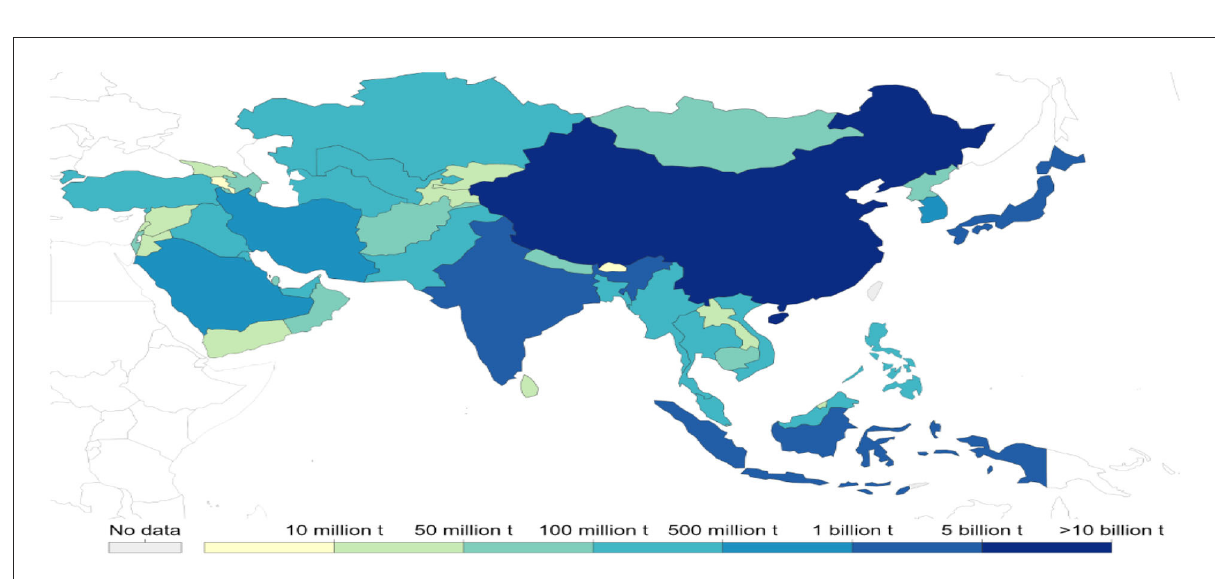
FIGURE4 Total greenhouse gasses (GHGs) emission includes emissions from land use changes and forestry from Asian countries (measured in tons of carbon dioxide equivalents [CO 2 -e] (Source: CAIT climate data explorer via Climate